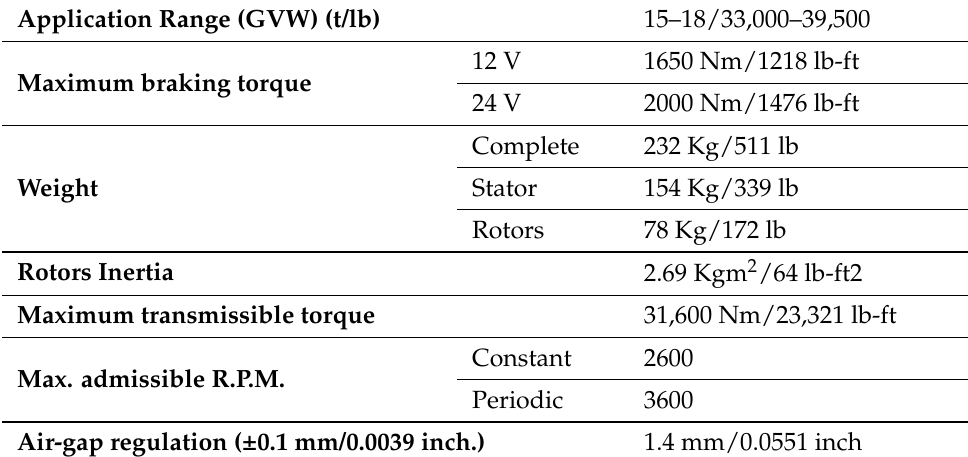
Table 2. CFK-200 driveline features.